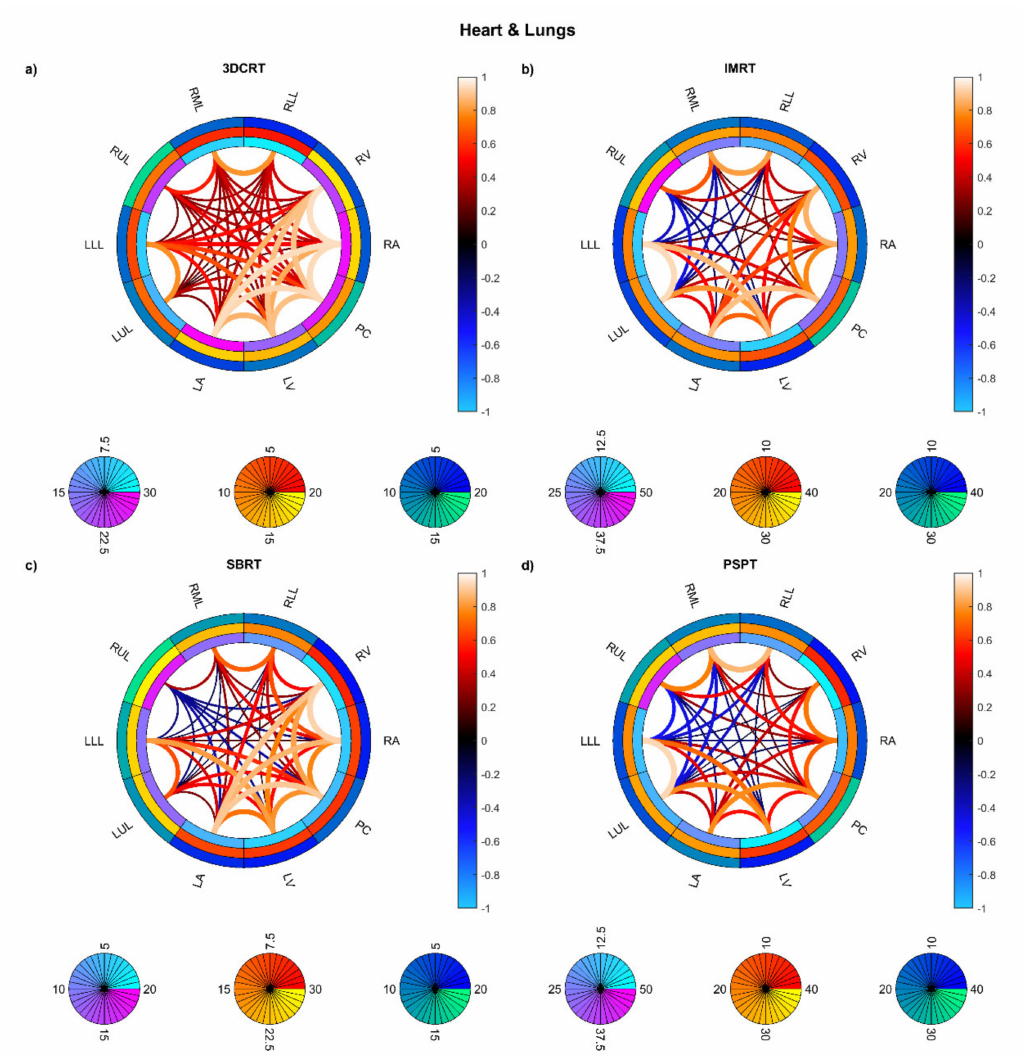
Figure 5. Connectograms in heart and lung substructures for the four groups of patients: Hodgkin lymphoma group— 3DCRT ( a ), non-small cell lung cancer patients treated with intensity-modulated radiation therapy—IMRT ( b ), NSCLC patients treated with stereotactic body RT—SBRT ( c ), NSCLC patients treated with passive-scattering proton therapy—PSPT ( d ). The pairwise Spearman correlation coefficients between mean biological effective dose (BED) values to the reported substructures are represented by the lines within the rings. From inside to outside, the rings represent the average of the substructure mean BEDs, standard deviation of the substructure mean BEDs, and average of the dose standard deviations within the substructure. BED is expressed in Gy. Abbreviations: LLL: left lung lobe; LUL: left upper lobe; RLL: right lower lobe; RML: right middle lobe; RUL: right upper lobe; LA: left atrium; LV: left ventricle; RA: right atrium; RV: right ventricle; PC: